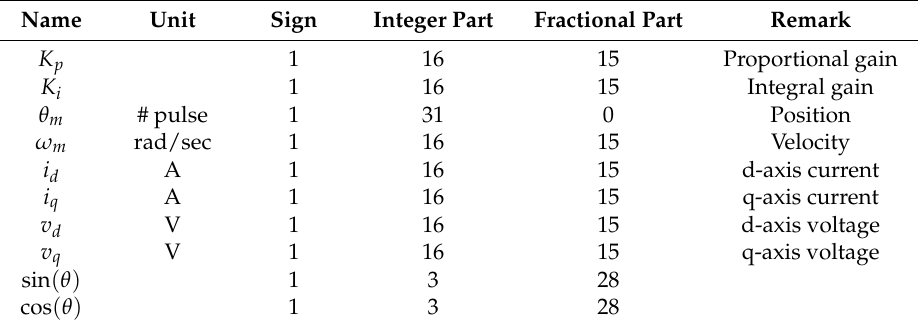
Figure 7. The data format for the reference frame transformation. Table 1. The data format of the variables and